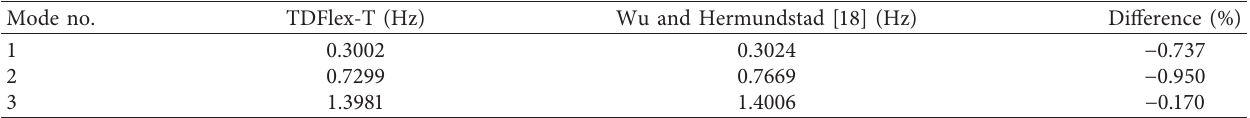
Table 3: Dry natural frequencies of the S175 for vertical flexural vibrations.